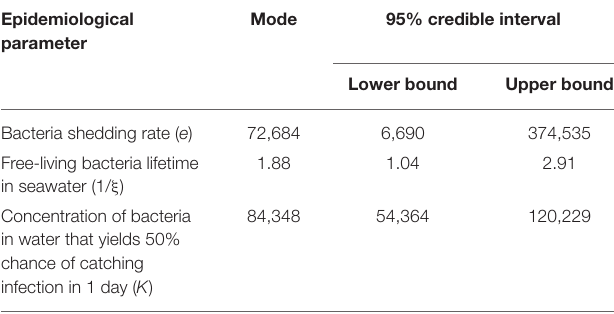
TABLE 5 | Estimated values and ranges of the model parameters of Vibrio aestuarianus transmission among oysters using Approximate Bayesian Computation (ABC; N =